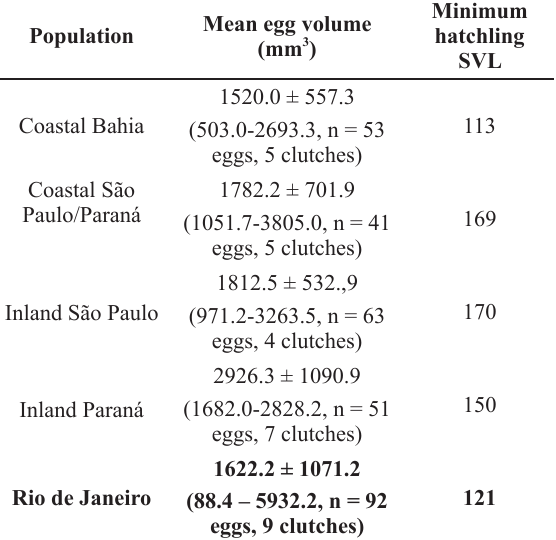
Average egg volume (in mm 3 , with range and sample sizes in parentheses) and size (SVL) of the smallest field- collected hatchling (in mm) of Erythrolamprus miliaris from Rio de Janeiro State (in bold) compared to other populations studied by Pizzatto and Marques (2006b).